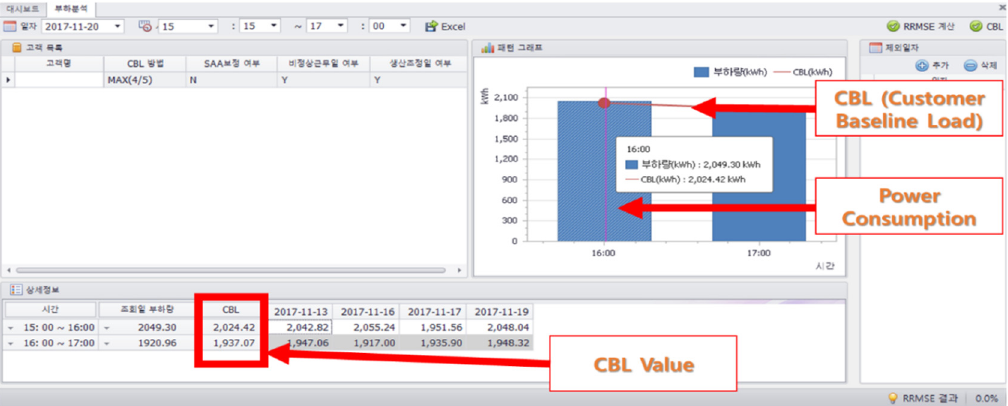
Figure 4. Customer baseline load calculation.